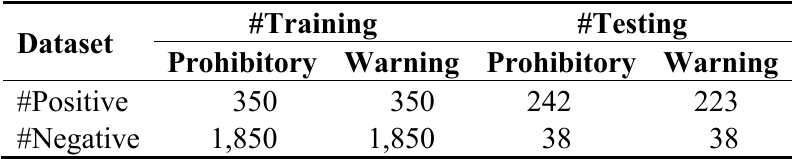
Table 3. The Adaboost classifier training and testing data.